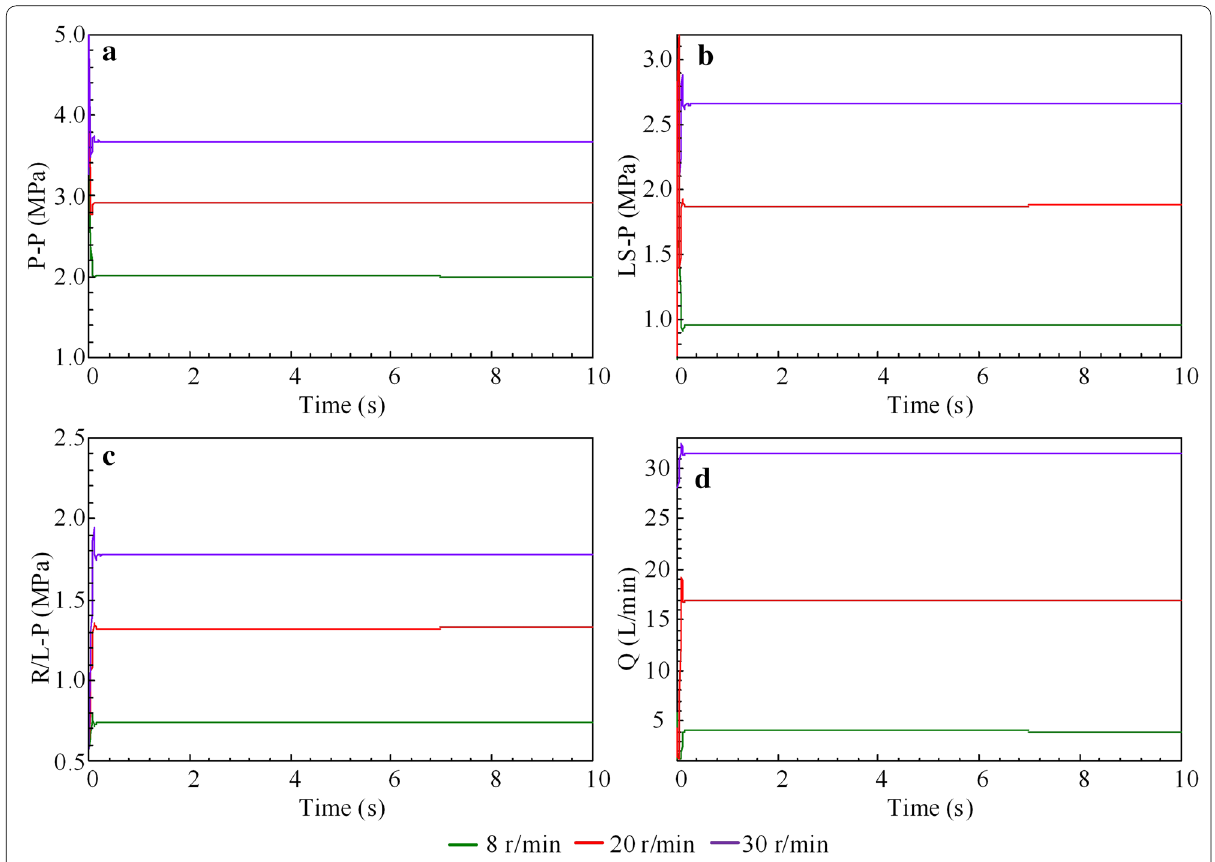
Figure 11. The experiment simulation platform mainly consisted of a priority valve, redirector, and equivalent load to form a load-sensing steering system. The main function of the priority valve was to ensure that the fluid in the main circuit was preferentially supplied to the steering system, and the excess fluid was unloaded through port EF of the priority